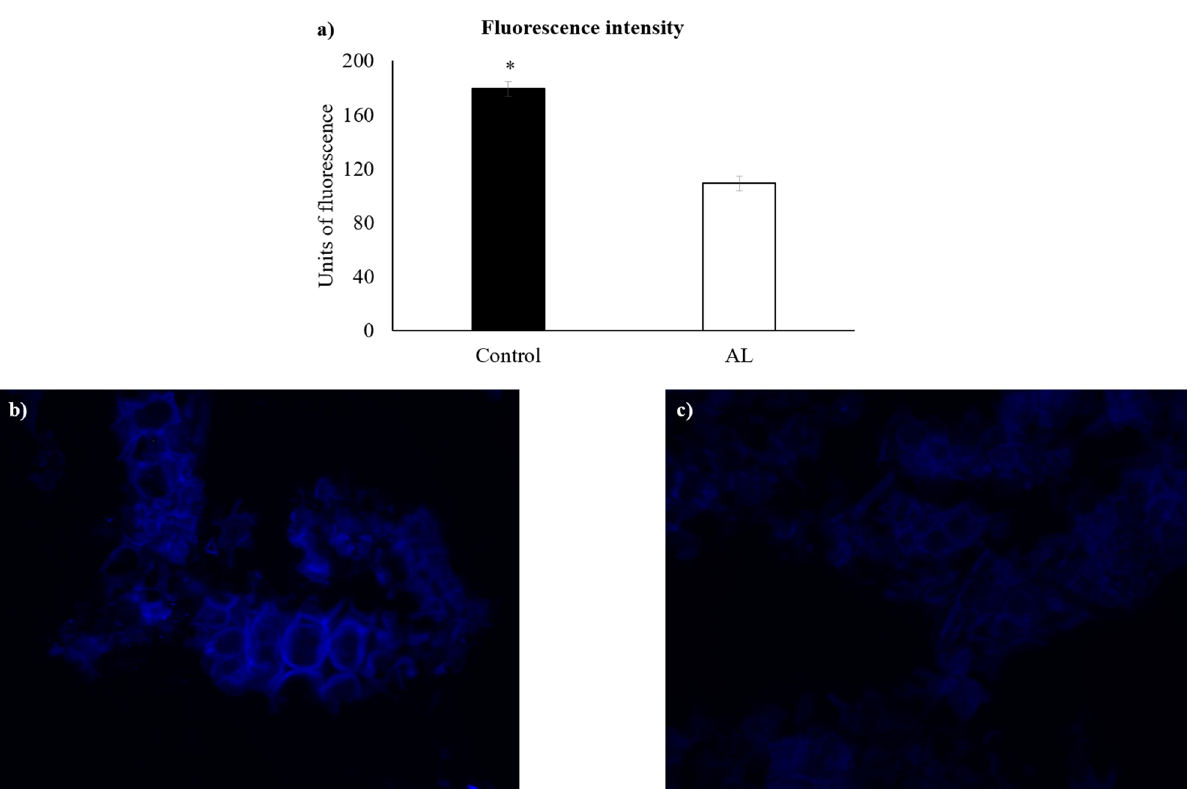
Figure 1. ( a ) Fluorescence intensity derived from Calcofluor White staining for control assay and alginate lyase (AL; ID 22) treatment. Asterisk denotes statistical difference at p = 0.001. ( b ) and ( c ): fluorescence images (× 400) of Laminaria digitata suspension stained with Calcofluor White for control assay and alginate lyase treatment,